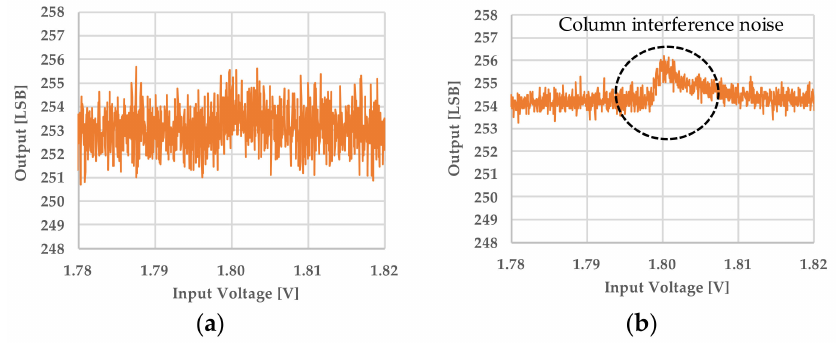
Figure 16. Comparison of accelerated column interference evaluation results between the conven- tional and the proposed evaluation system. ( a ) shows the measurement result using the conventional evaluation system and ( b ) shows the result using the proposed evaluation